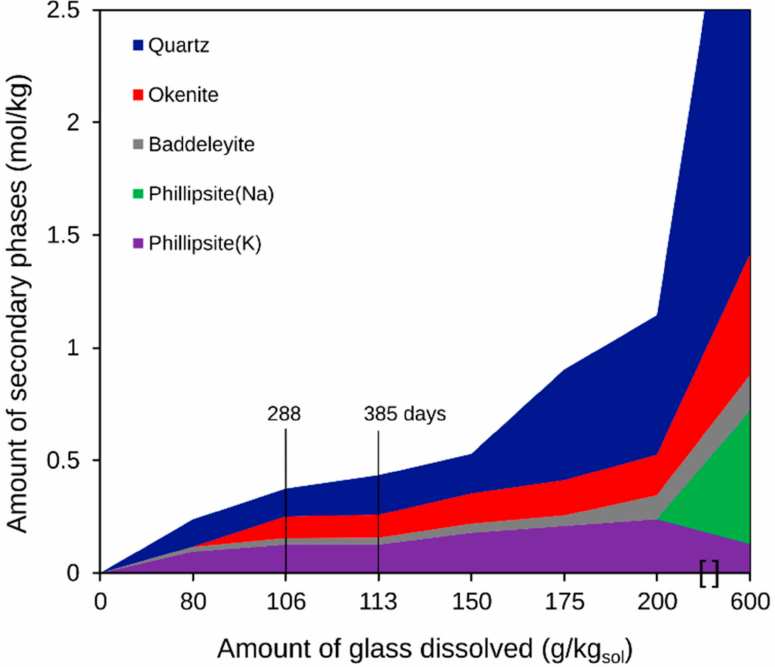
Figure 3. Predicted secondary phases formed following a sequential congruent glass dissolution up to 600 g of ISG in 1 kg of YCWCa. The amounts of 106 g and 113 g of dissolved glass correspond to the solution composition after 288 and 385 days in the dissolution experiments, respectively.